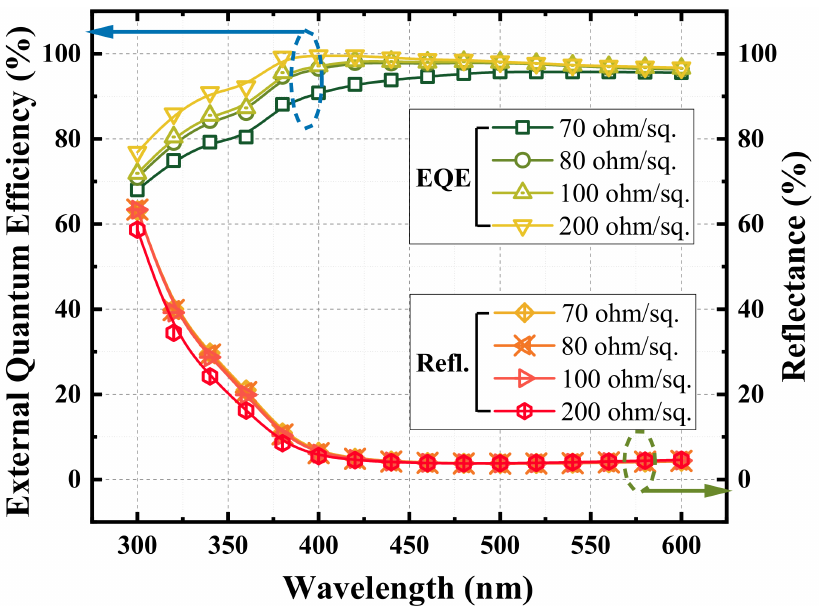
Figure 5. External quantum e ffi ciency and reflectance analysis with respect to R sheet variation.